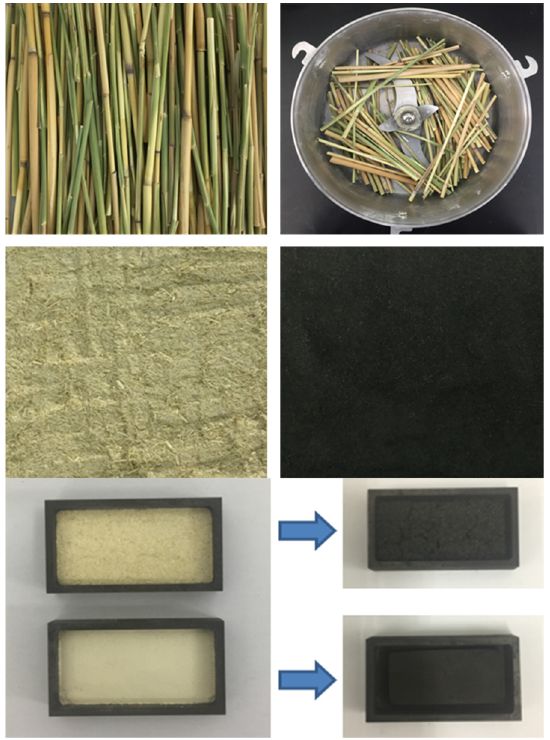
Figure 4. Biochar electrodes’ preparation schematic diagram.